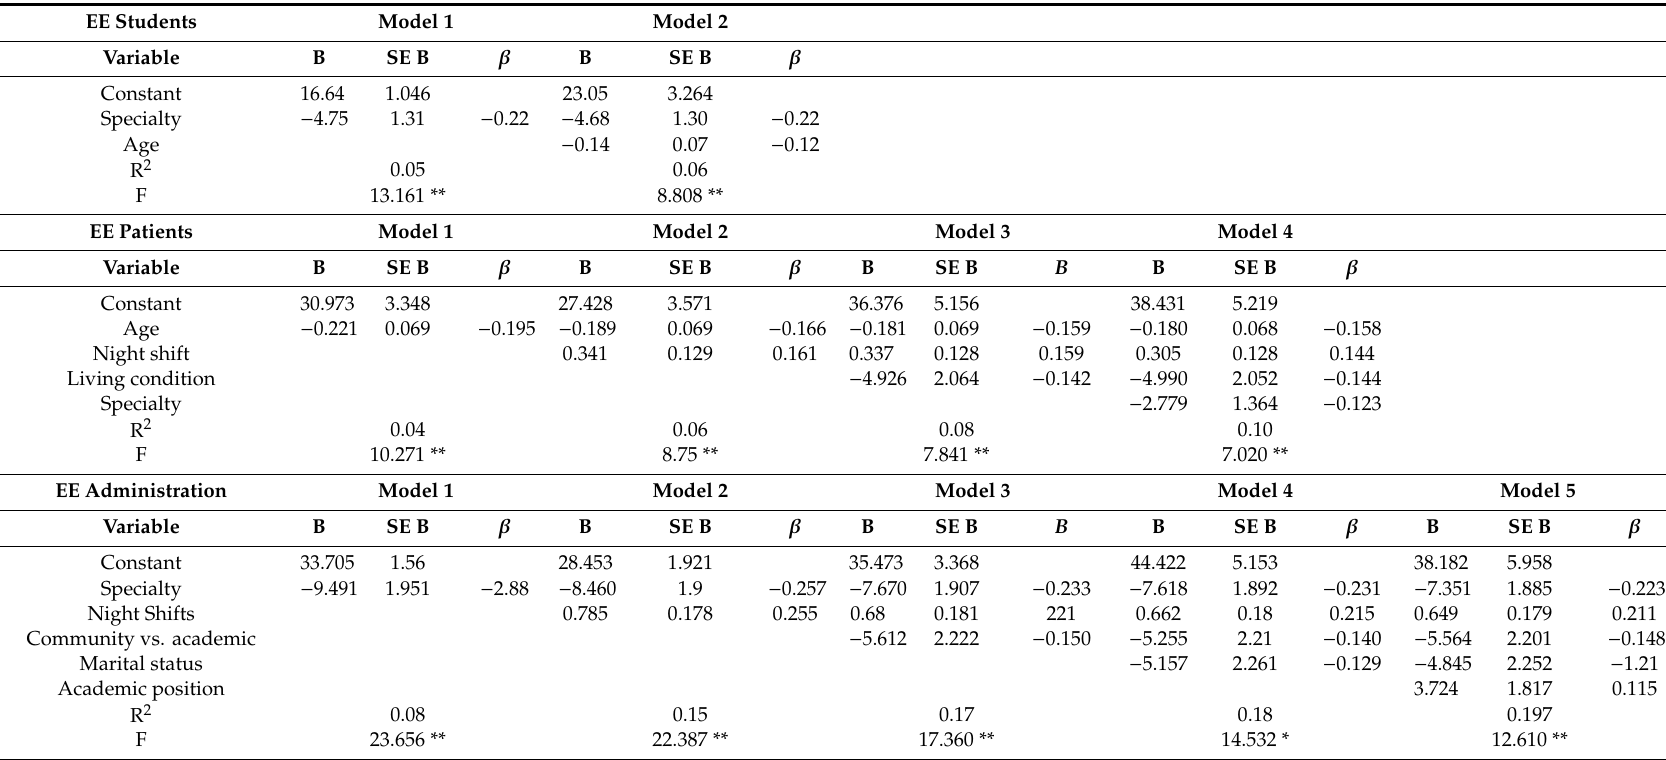
Table A4. Linear Regression for emotional exhaustion (EE)